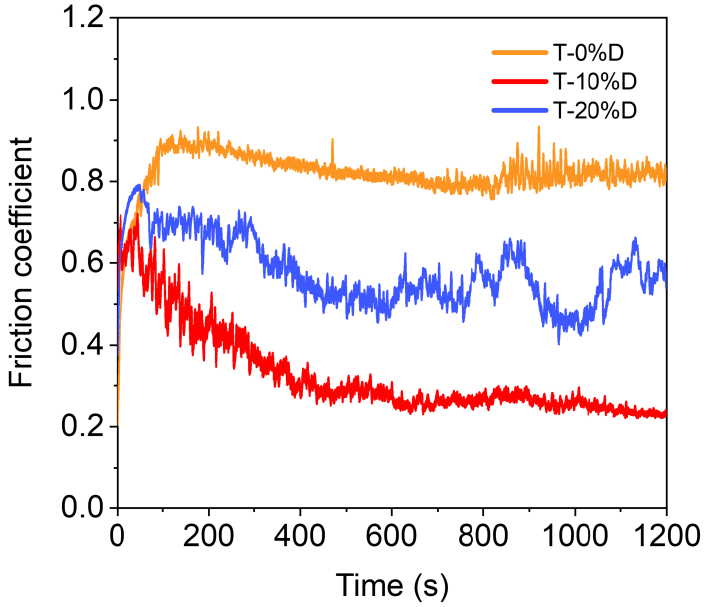
Figure 9. The friction coefficient of the TiO 2 -diamond composites as a function of time.